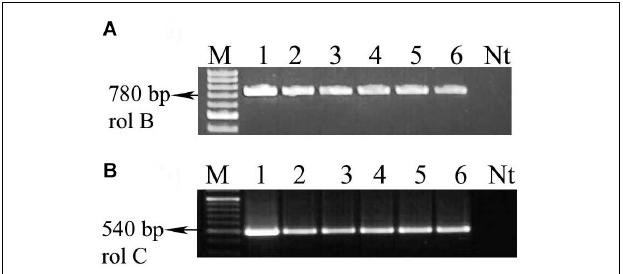
FIGURE 8 | PCR conformations of transgenic hairy roots (A 4 and R 1000 ) from A. vulgaris L. leaf explants. (A) rolB gene amplification (780 bp). (B) rolC gene amplification (540 bp). Lane M: marker, lane 1: A 4 plasmid DNA, lane 2: R 1000 plasmid DNA, lanes 3 and 4: genomic DNA of hairy root culture (A 4 strain), lanes 5 and 6: genomic DNA of hairy root culture (R 1000 strain), Nt: non-transgenic root.